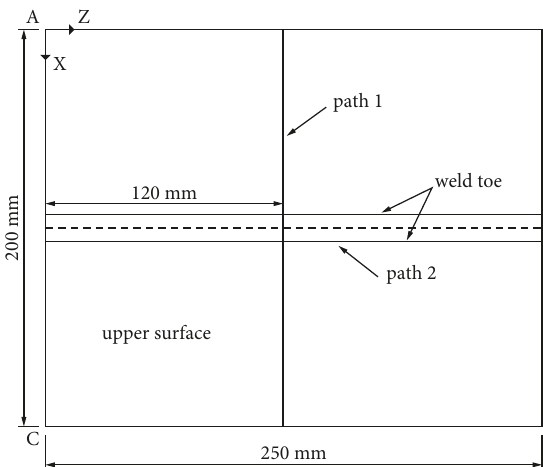
Figure 16: Schematic diagrams of path 1 and path 2.